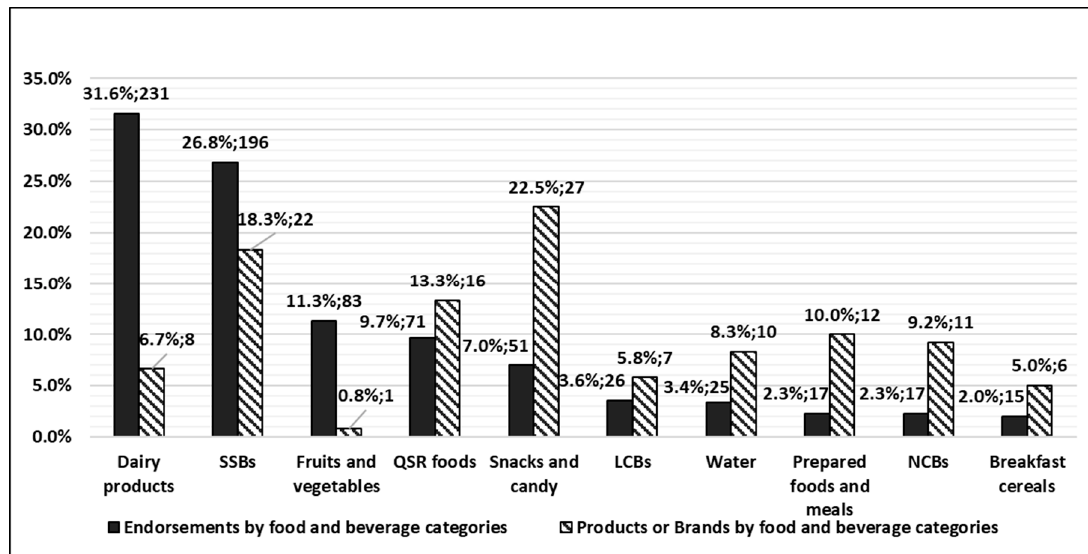
Figure 1. Comparison for the percentages and numbers of endorsements ( n = 732) and the number of unique brands or products ( n = 120) by food and beverage categories ( n = 10). Abbreviations: quick-service restaurant (QSR); sugar-sweetened beverage (SSB); low-calorie beverage (LCB); no-calorie beverage (NCB).